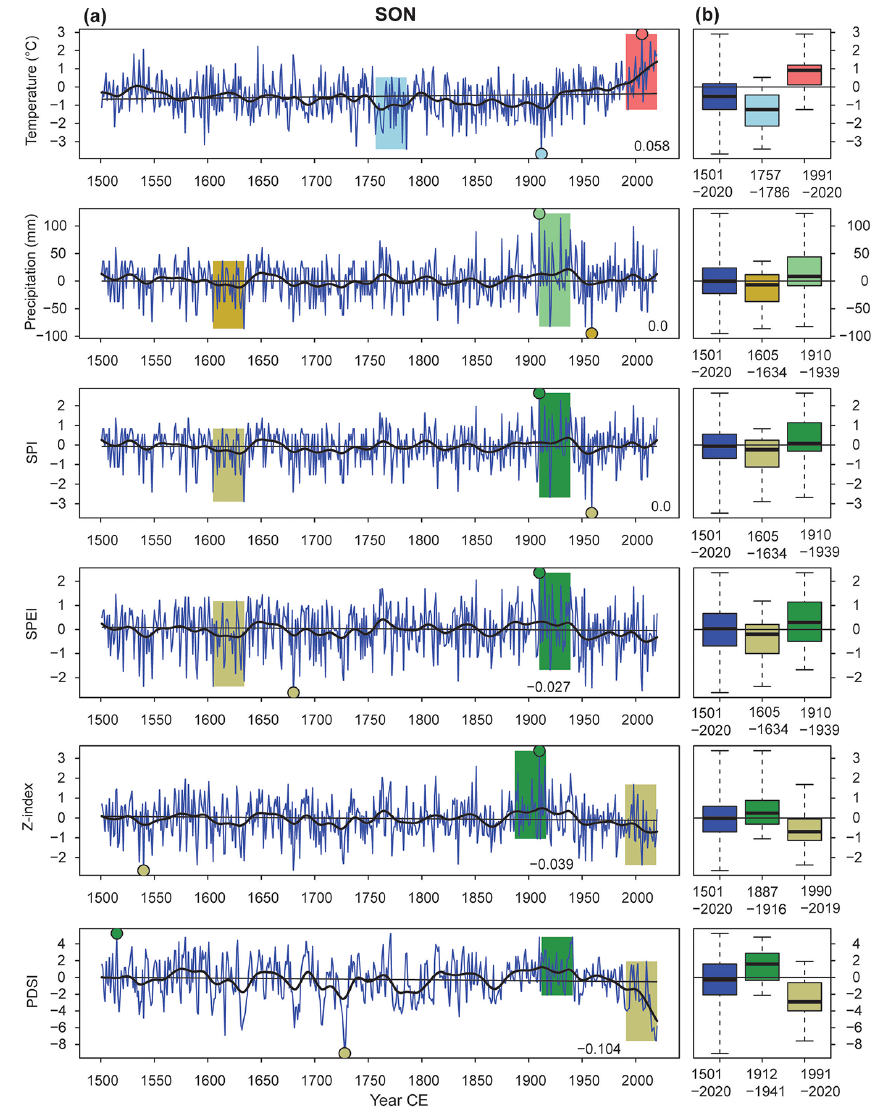
Figure 6. See text in Fig. 1;